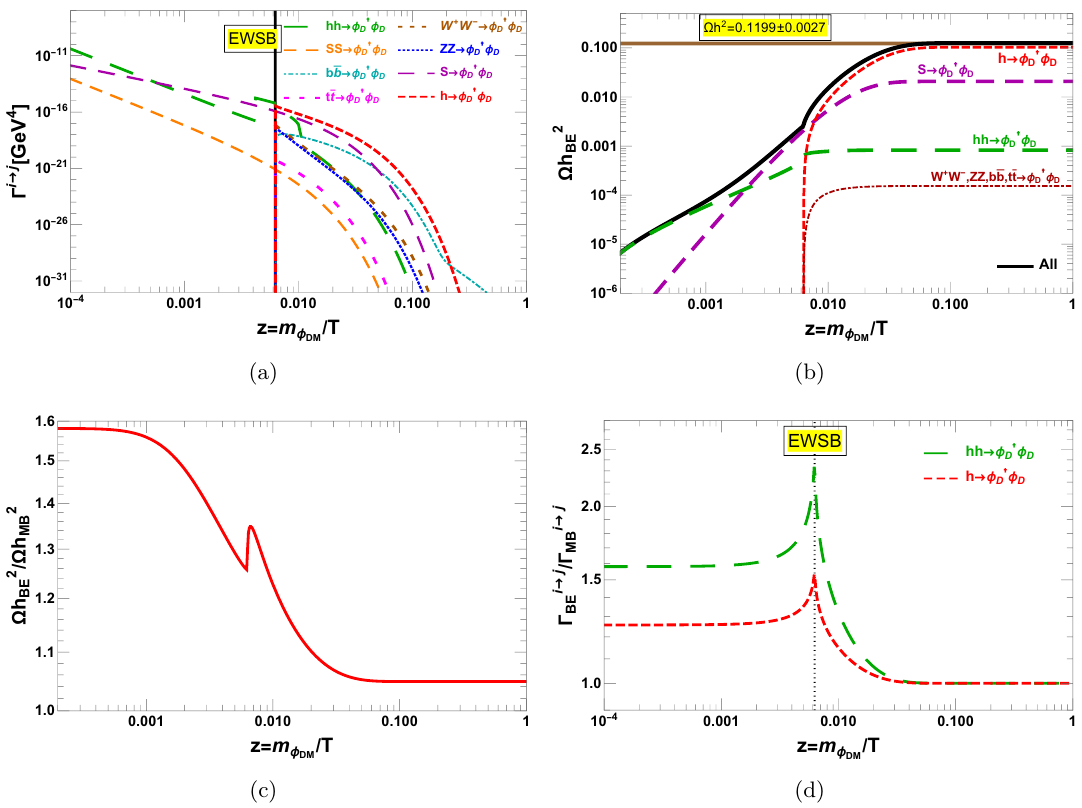
Figure 9 . The figures correspond to Scenario-5 . Figure 9(a) shows the relativistic reaction rates for the process hh, SS → φ ∗ φ D , and h, S → φ D φ D . Figure 9(b) shows the individual contributions D to the relic density, and the total relic density. The brown horizontal line represents the present experimentally measured relic density [54]. Figure 9(c) shows the relative enhancement in the relic density as compared to Maxwell-Boltzmann distribution and figure 9(d) shows the relative enhancement in the respective reaction